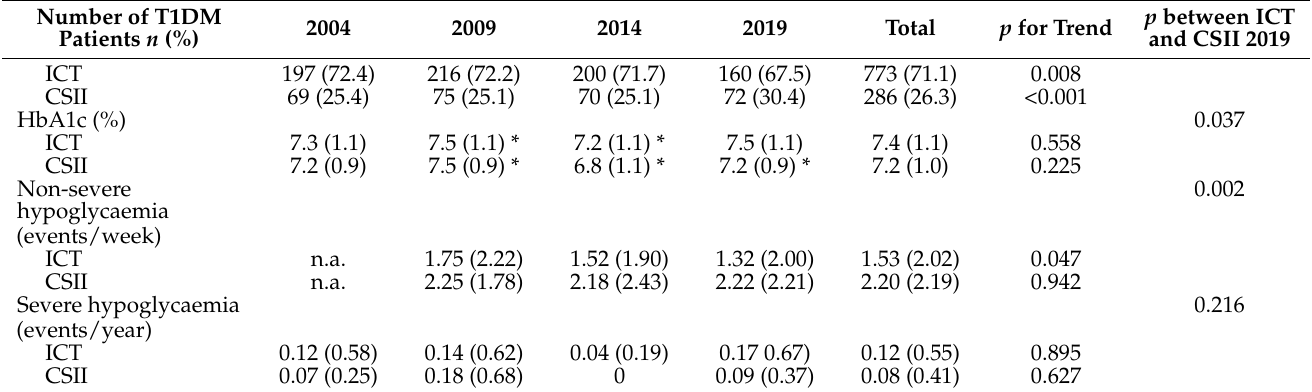
Table 7. Comparison between T1DM patients treated with ICT or CSII in secondary care (SC).